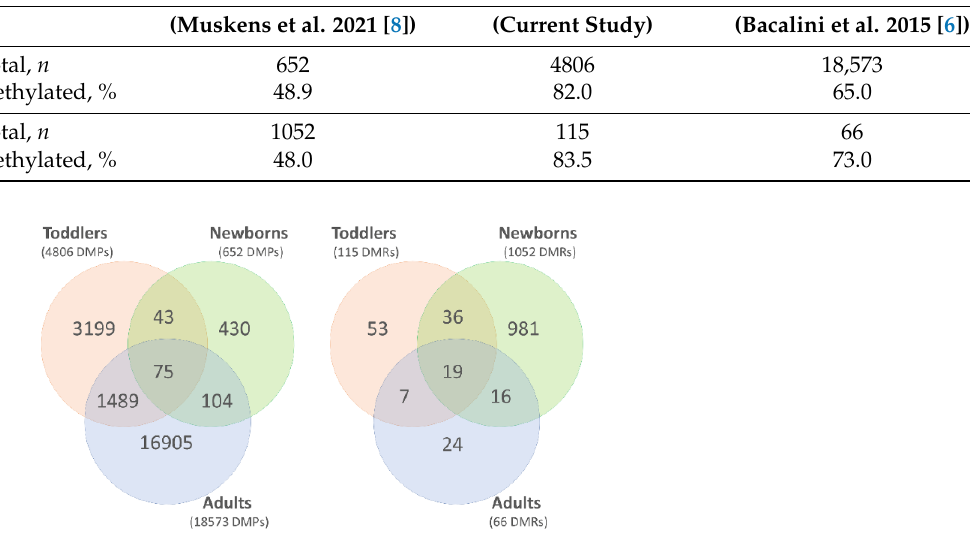
Figure 7. The distribution and overlapping of differentially methylated positions (DMPs; left ) and differentially methylated regions (DMRs; right ) identified in three epigenome-wide association studies in the individuals with Down syndrome of different ages: newborns [8], toddlers (current study), and adults [6].